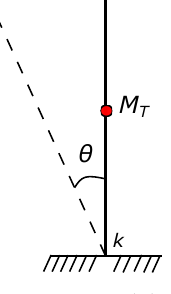
Figure 5. Model of the